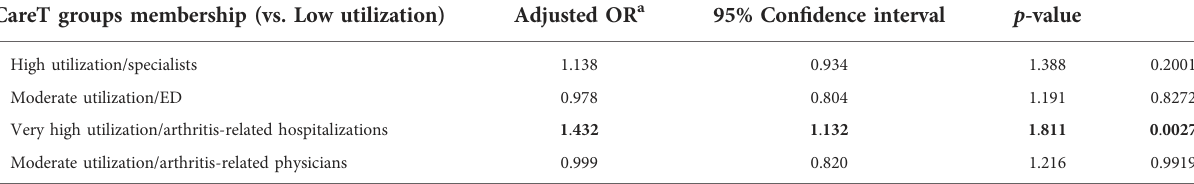
TABLE 5 Multivariable logistic regression model exploring associations between CareT groups membership and greater pain interference (some/ most activities prevented by pain or discomfort). CareT groups membership (vs. Low utilization)